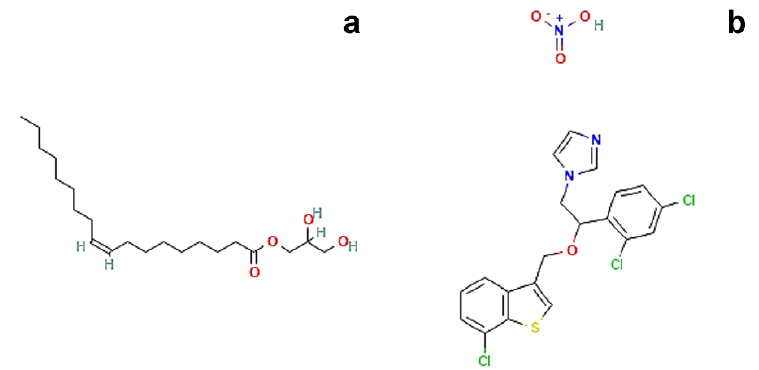
Figure 1. Chemical structures of ( a ) Glycerol monooleate. Available online: https://pubchem.ncbi.nlm.nih.gov/compound/5283468#section=2D-Structure (accessed on 19 September 2022, [15]) and ( b ) Sertaconazole nitrate. Available online: https://pubchem.ncbi.nlm.nih.gov/compound/200103#section=2D-Structure (accessed on 19 September 2022, [16]).